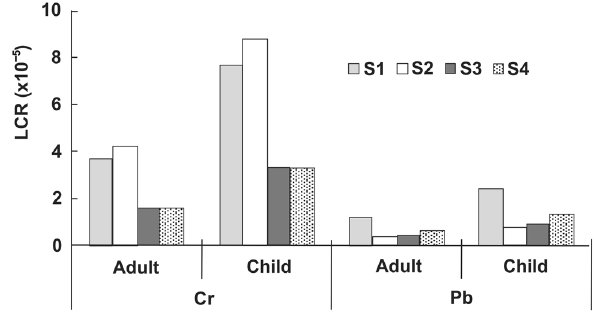
Fig. 2 Lifetime cancer risk (LCR) indicating the carcinogenic risk Table 3 Correlation of Cr, Pb, and Zn concentrations in drinking water from Jengka